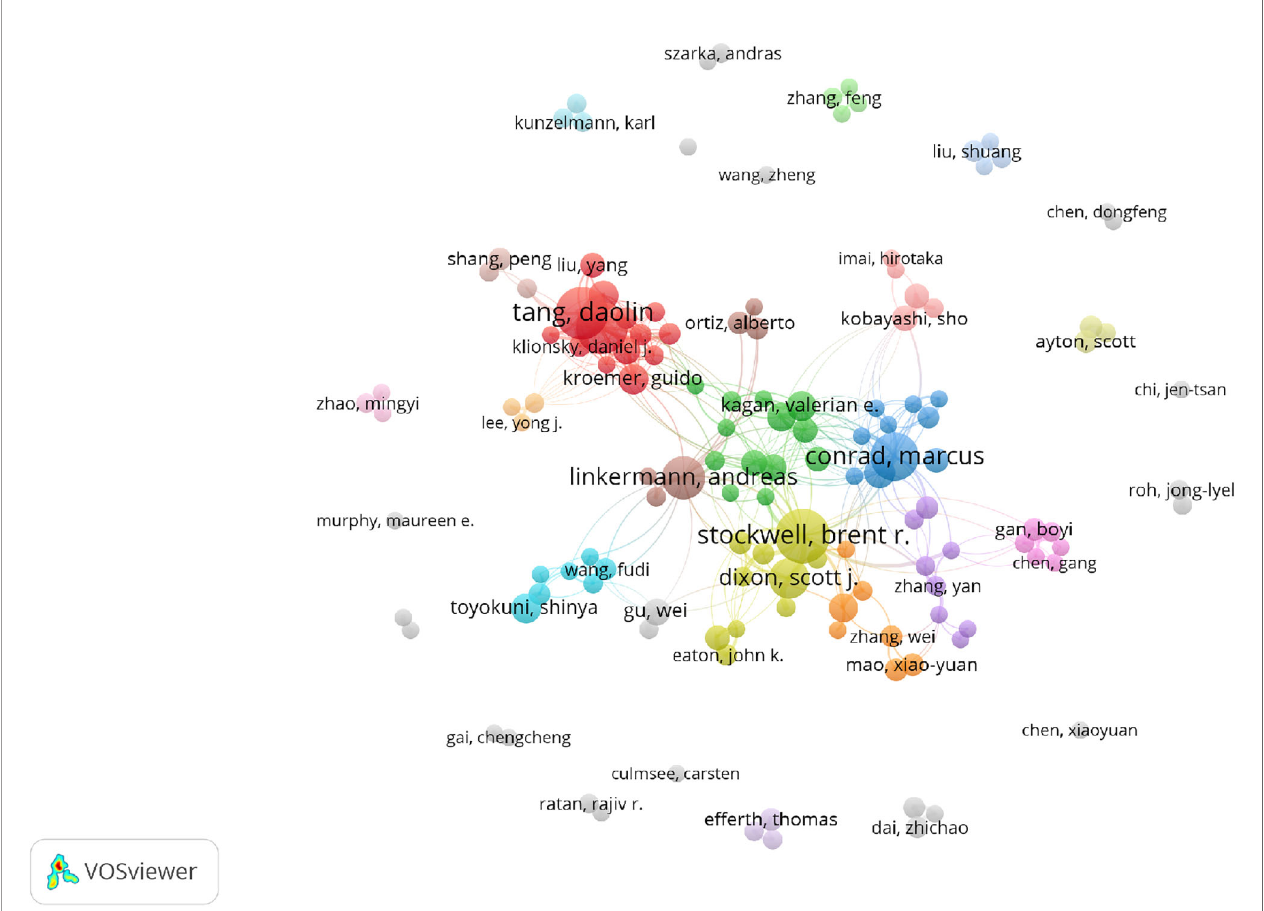
FIGURE 4 | The co-occurrence map of authors in ferroptosis research (T ≥ 5). Notes: The size of node re fl ects the author ’ s co-occurrence frequencies, the link indicate the co-occurrence relationship between authors, and the same color of node represent the same